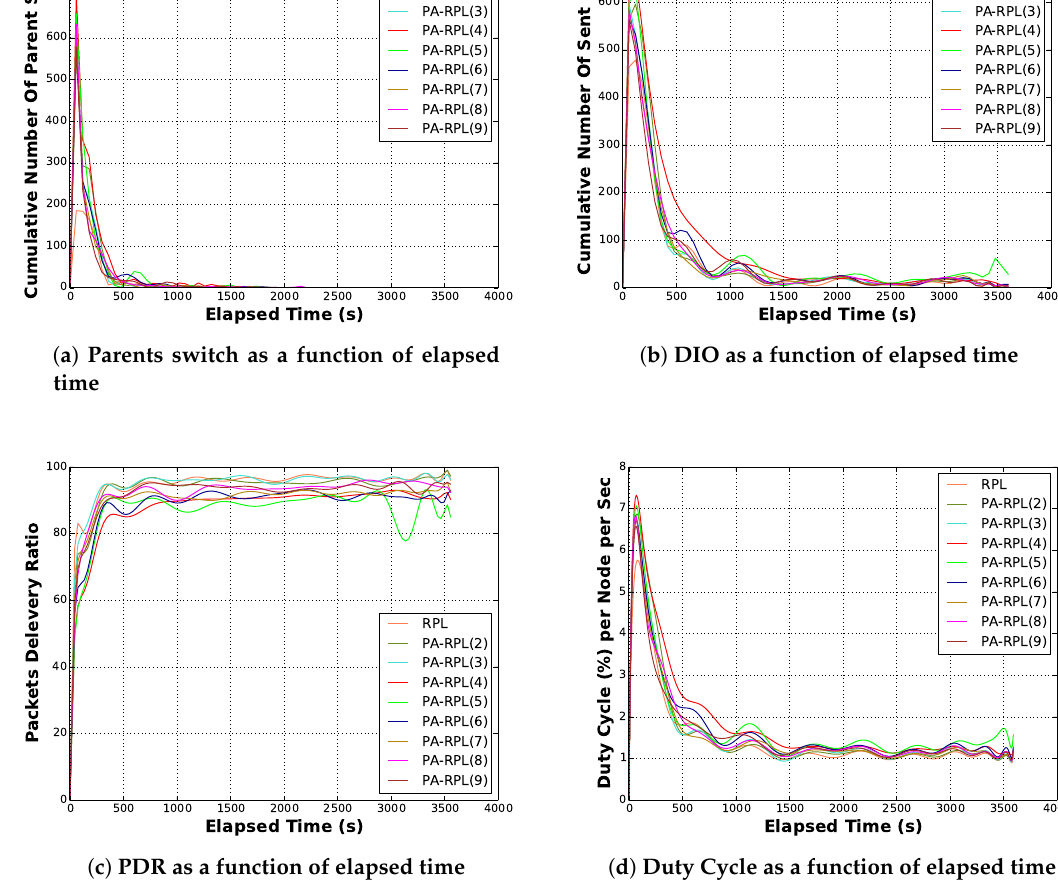
Figure 13. PA-RPL performance as a function of elapsed